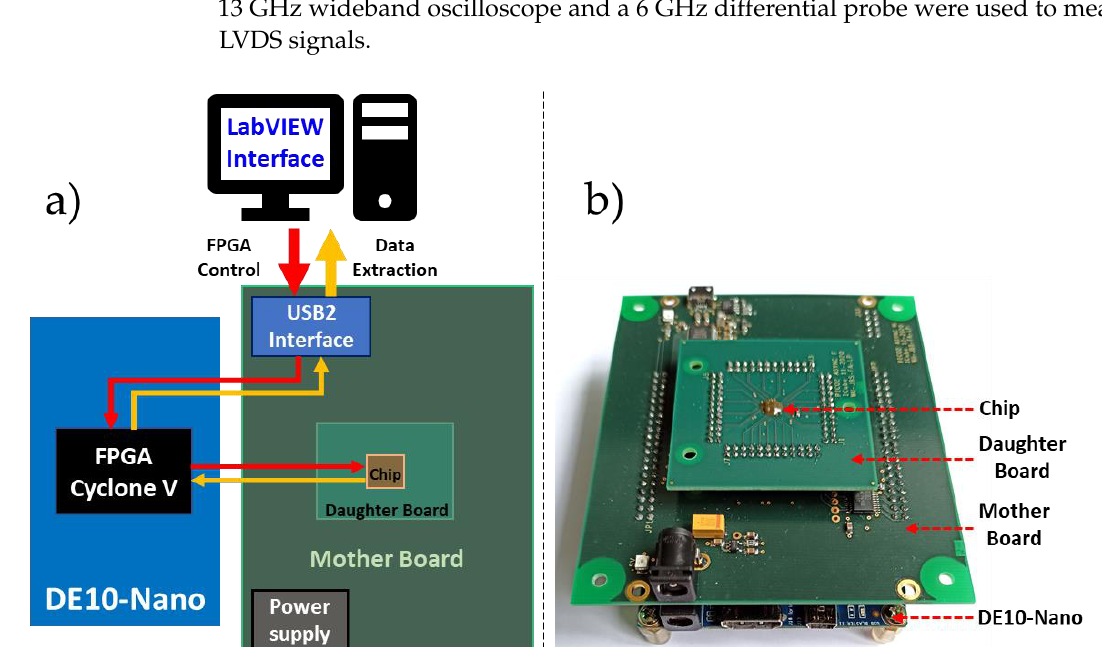
Figure 12. ( a ) Block diagram of the experimental setup which consists of a stack of three boards: a daughter board with the design CHIP, a motherboard which meanly provides the power supply, and the USB2 interface and a commercial FPGA design kit. ( b ) Picture of the experimental